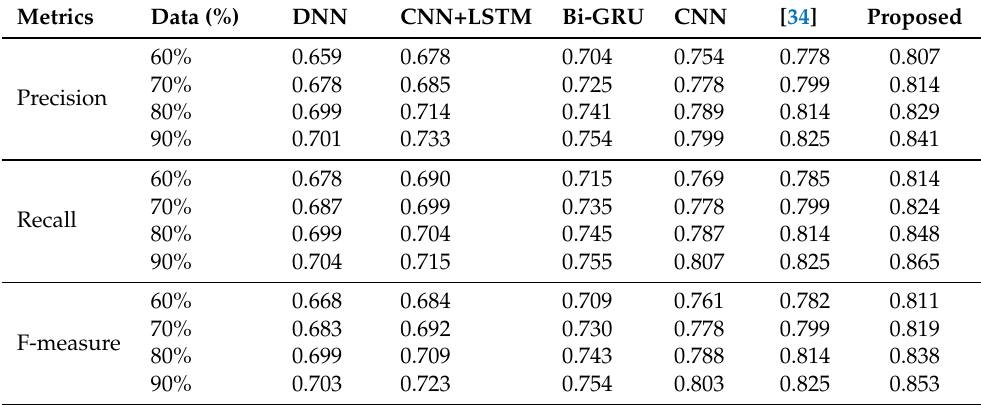
Table 8. Comparative analysis of Review Rating Prediction for social media app review dataset in terms of precision, recall and